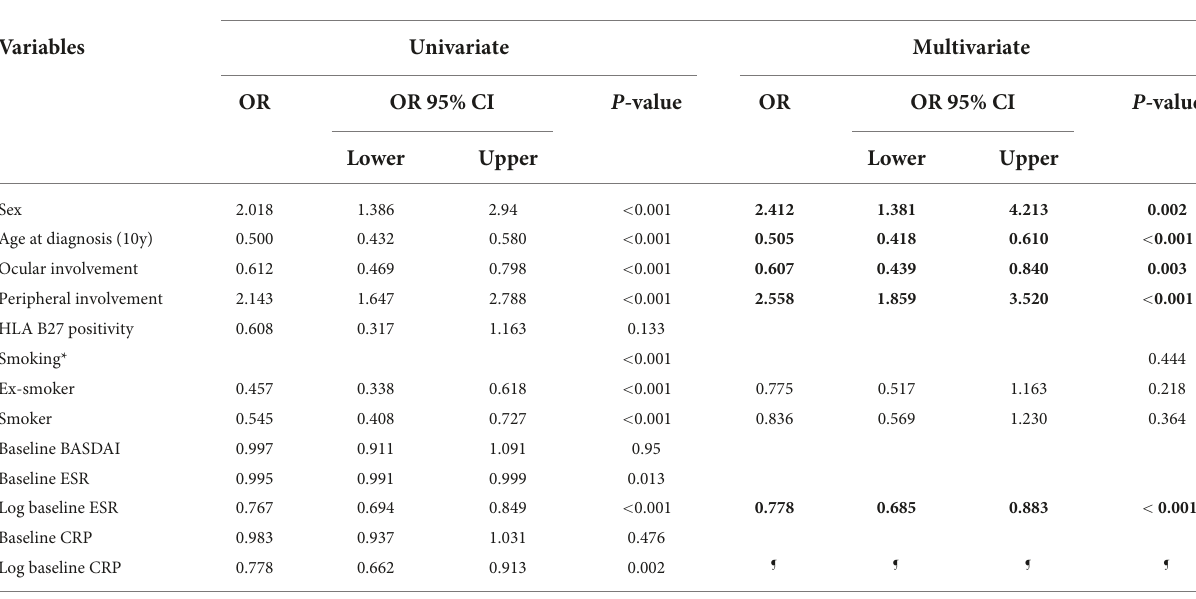
TABLE 3 Multivariate logistic regression analysis for associated factors of mSASSS progression according to disease